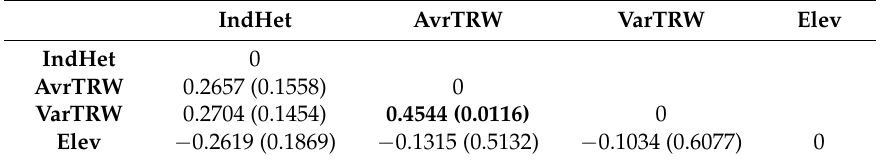
Table 2. Pearson’s correlation coefficients with p -values in parentheses calculated in 30 trees to assess associations between tree growth (average tree-ring width (AvTRW) and variance (VarTRW)), elevation (Elev, m) and individual genomic diversity (IndHet). Bold values are significant at p < 0.05.